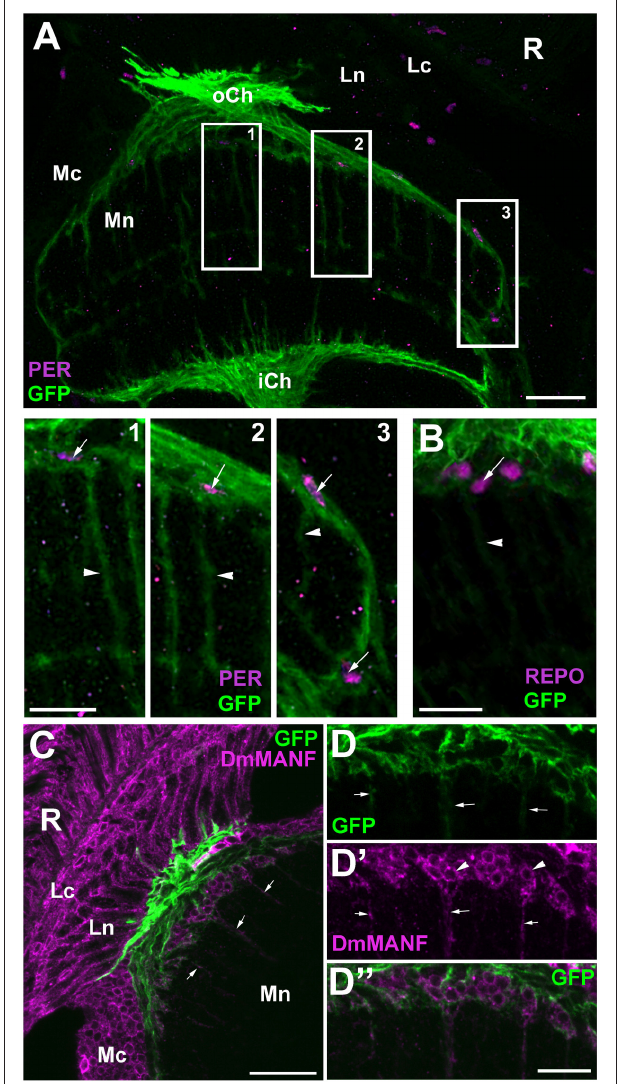
FIGURE 6 | (A) Horizontal section of the medulla of NP6520 -Gal4/UAS- mCD8-GFP flies immunolabeled with anti-PER antibody. The nuclei of GFP-expressing EnGl (frames 1–3) are PER-positive, which is well visible in higher magnification (panels 1–3). The processes of EnGl (arrowheads in panels 1–3) span the medula neuropil (Mn). R, retina; Lc, Lamina cortex; Ln, lamina neuropil; oCh, outer chiasm; Mc, medulla cortex; iCh, inner chiasm. Scale bars: 20 µ m for (A) and 10 µ m for panel 1, 2, and 3. (B) The nuclei of GFP-positive EnGl show high level of REPO-specific immunofluorescence (arrow). Arrowhead-the EnGl processes. Scale bar: 10 µ m. (C) The distal part of the medulla in horizontal section of NP6520 -Gal4/UAS-mCD8-GFP flies immunolabeled with anti-DmMANF antibody. The processes of EnGl are marked with arrows. R, retina; Lc, lamina cortex; Ln, lamina neuropil; Mc, medulla cortex; Mn, medulla neuropil. Scale bar: 20 µ m. (D-D”) Higher magnification of EnGl marked in (C) . The GFP-positive processes of EnGl ( D , arrows) are marked with DmMANF (D’,D”) . DmMANF is also visible in the perinuclear space of cell bodies in the medulla cortex (D’, arrowheads). Scale bar: 10 µ